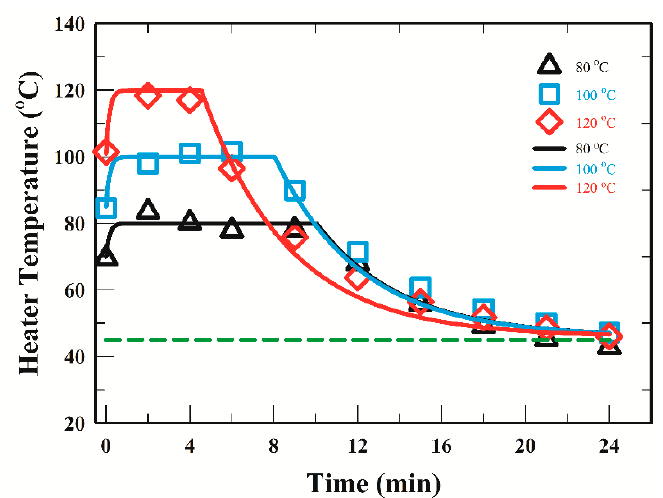
Figure 2. Profiles of the inlet air temperature (the heater temperature) during wheat germ drying in the FBD at different set temperature. The symbols represent the experimental data; the solid lines represent the simulated values; the dashed line represents the product temperature of 45 °C.